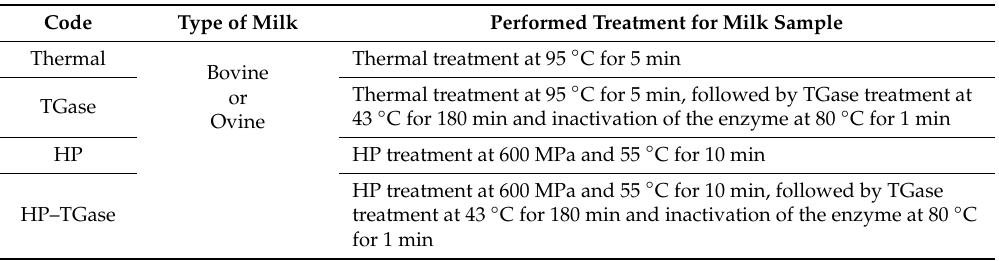
Table 1. List of the experimental milk samples